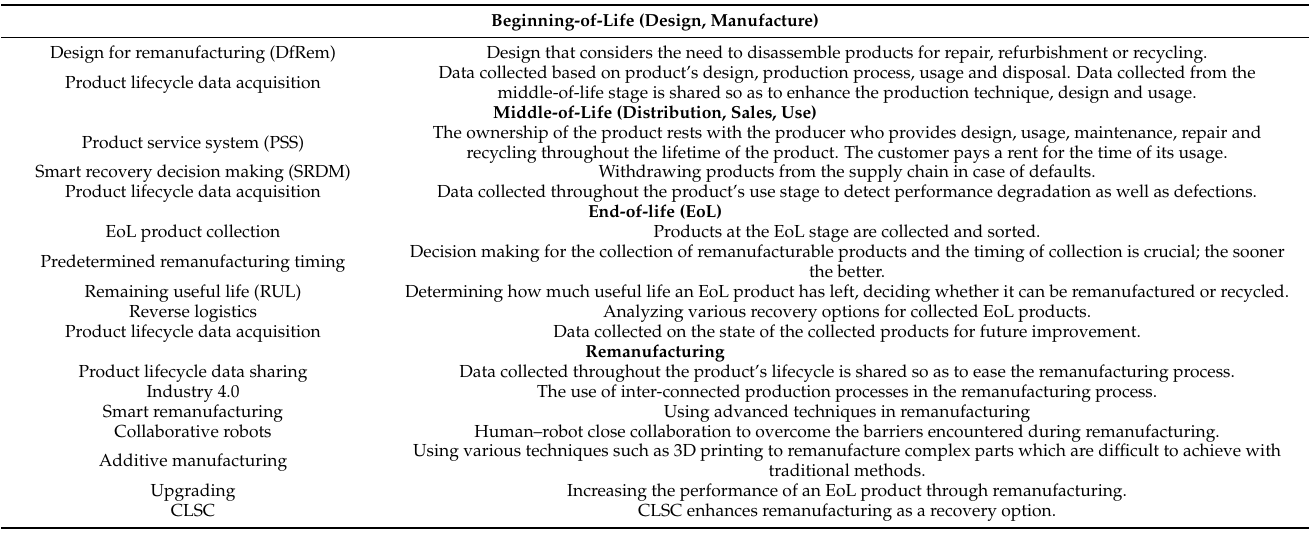
Table 2. Database of strategies to enhance